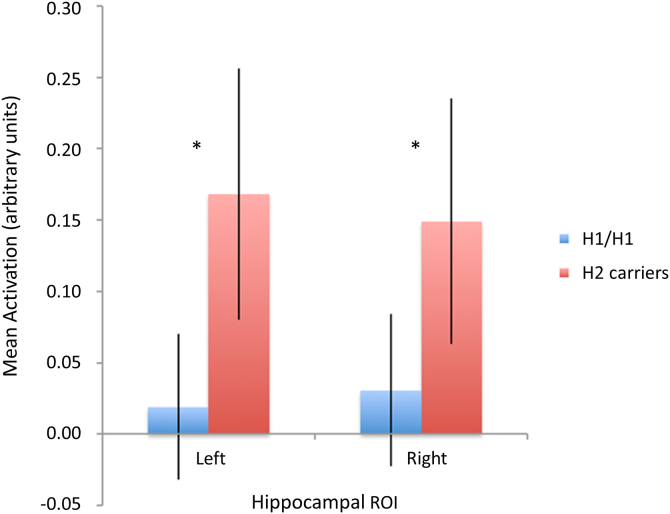
Activation in the hippocampal regions of interest (ROI) during successful encoding (contrast 1: successful minus unsuccessful encoding) in all participants stratified by MAPT haplotype. ROIs were defined anatomically using AAL templates, and activation is expressed in arbitrary units using the mean parameter estimates from the ROI. *p < 0.05 (2-tailed t tests). Error bars indicate ± 1 SEM. Abbreviations: AAL, anatomical labeling atlas; PD, Parkinson's disease; SEM, standard error of the mean.